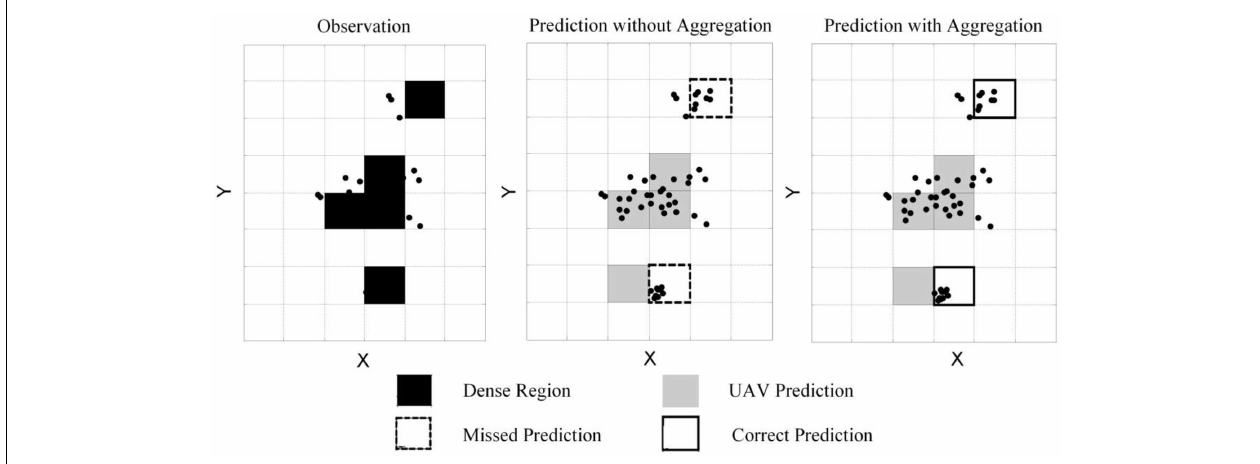
FIGURE 8 | Illustration of simulation outcome at time t = 8 . Black filled square: dense region in reality. Gray filled square: predicted region based on UAV’s data. Dashed square: missed prediction based on UAV’s data. Solid square: corrected prediction with aggregated data from UGVs.